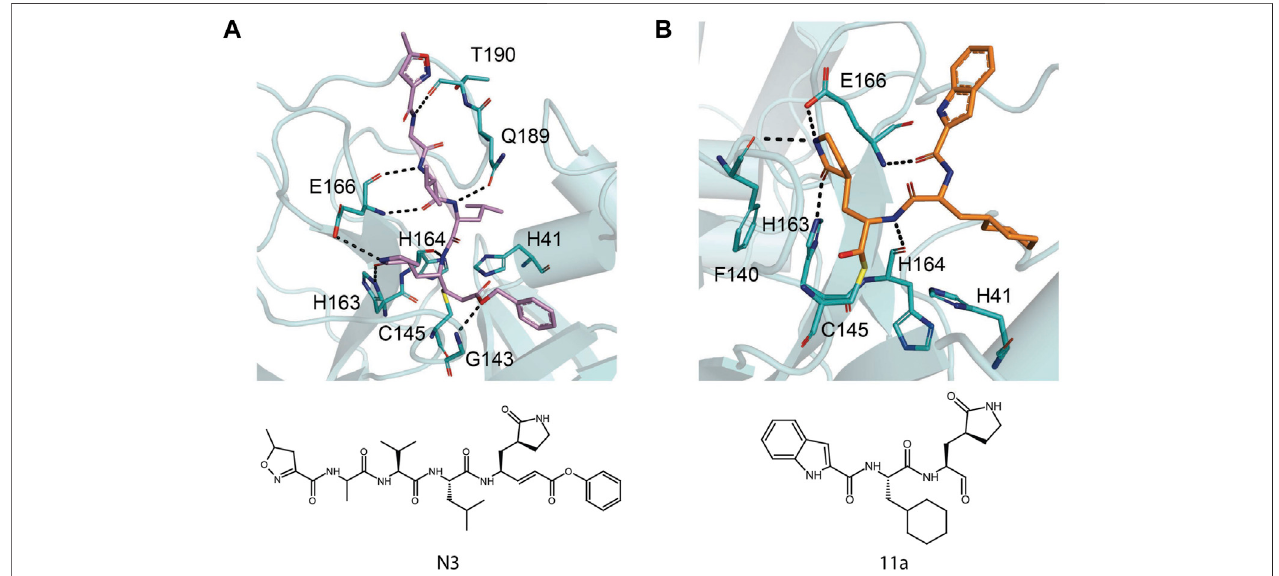
FIGURE 12 | Close-up view of the interactions between SARS-CoV-2 Mpro with N3 and its derivative 11a. Close-up view of interaction between SARS-CoV-2 Mpro and inhibitors in crystal structures. Mpro is shown as cartoon representation, with residues involved in the interaction shown as sticks. Inhibitors are shown as sticks. Hydrogen bonds were labeled with dashed lines. (A) N3 (PDB: 6LU7), violet. (B) 11a (PDB: 6LZE), orange.